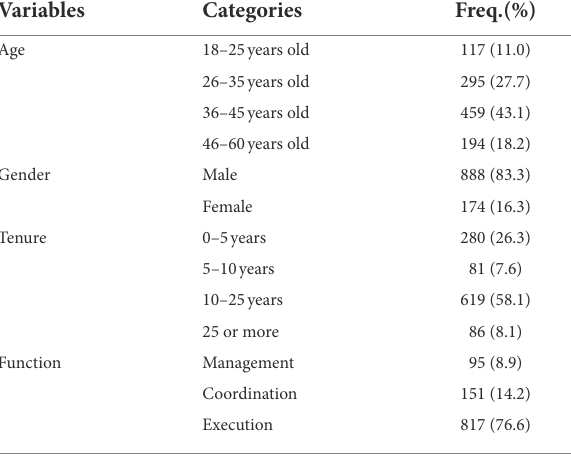
TABLE 1 Demographic profile of participants of the study ( N =